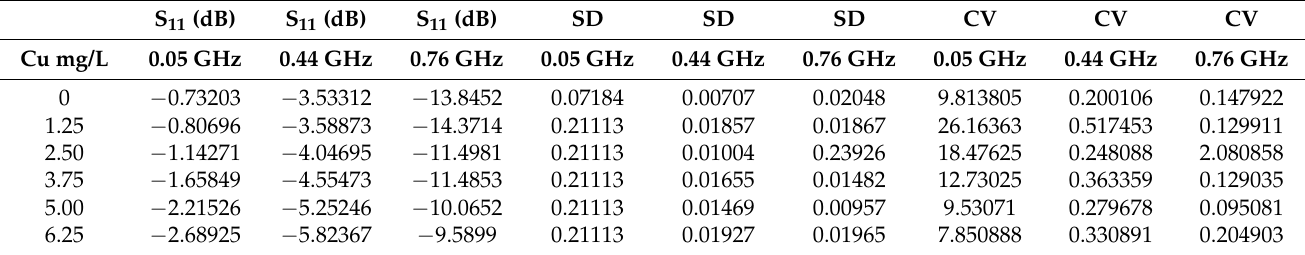
Table 4. Statistical features, mean, SD and CV for a collected water sample (NC) spiked with Cu standard addition (+1.25